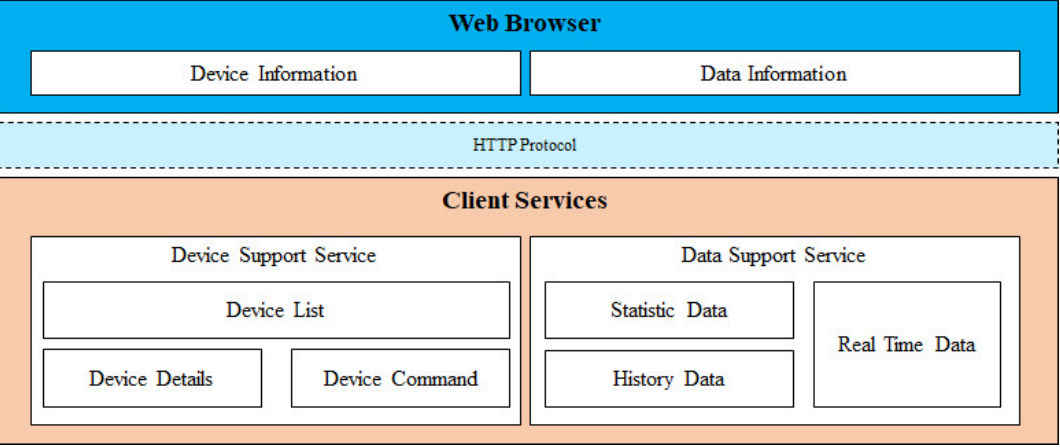
Figure 3. Development Model of Client Services.